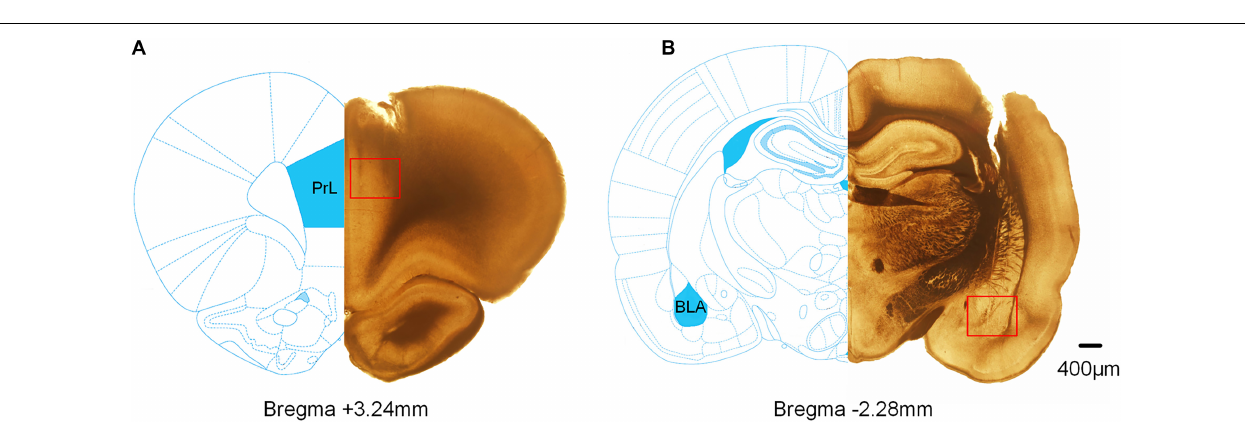
FIGURE 8 | Histological verification of the recording sites in the mPFC and BLA. The superimposed schematics show the coronal brain sections at 3.24 mm anterior and 2.28 mm posterior to the bregma. The red square refers to the track of the electrode tips. (A) The track of the recording electrode in the mPFC. (B) The track of the recording electrode in